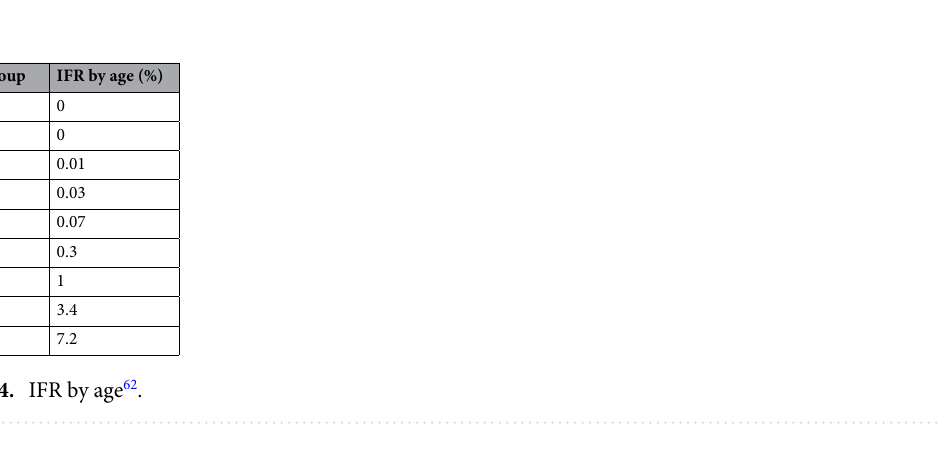
Table 3. Confidence intervals (CI) characteristics.